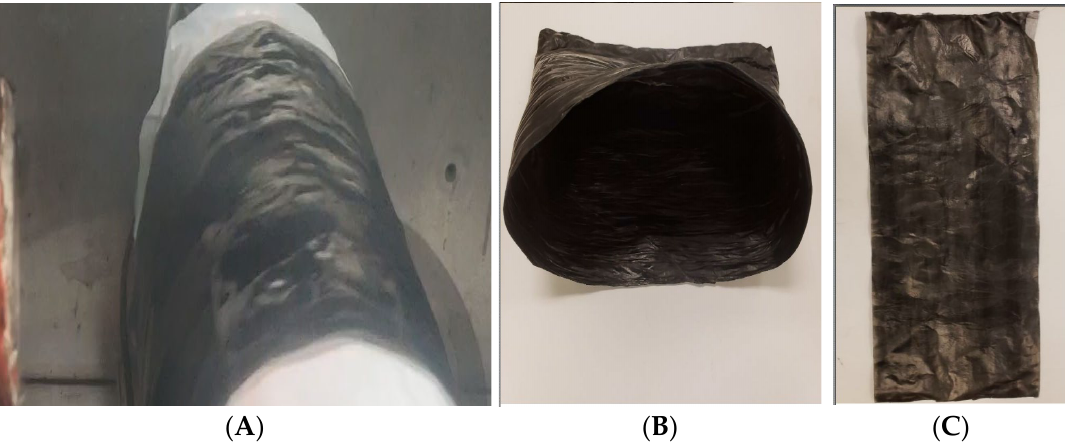
Figure 1. Synthesis process of CNT sock (the sock is a cylindrical web of CNT). ( A ) sock collection process; ( B ) obtained sheet from the drum after synthesis; ( C ) unfolded CNT sheet.